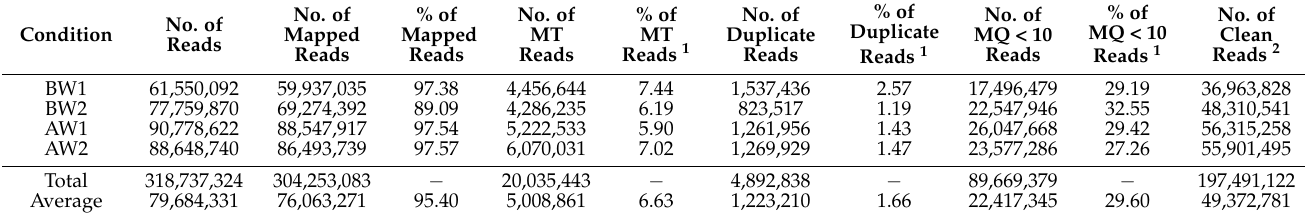
Table 1. Sequence read statistics showing the number of reads, number and percentages of mapped reads, mitochondrial reads, duplicate reads and reads with mapping quality < 10, and the number of clean reads used for peak calling.